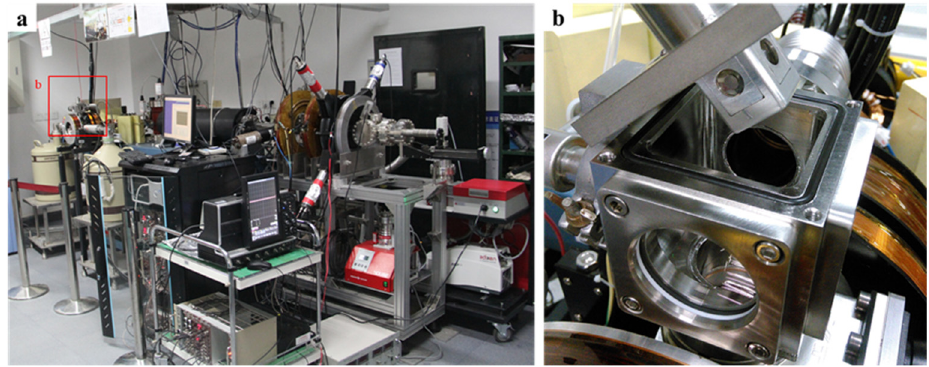
Figure 2. ( a ) Slow positron annihilation DB facility. ( b ) Sample assembly.